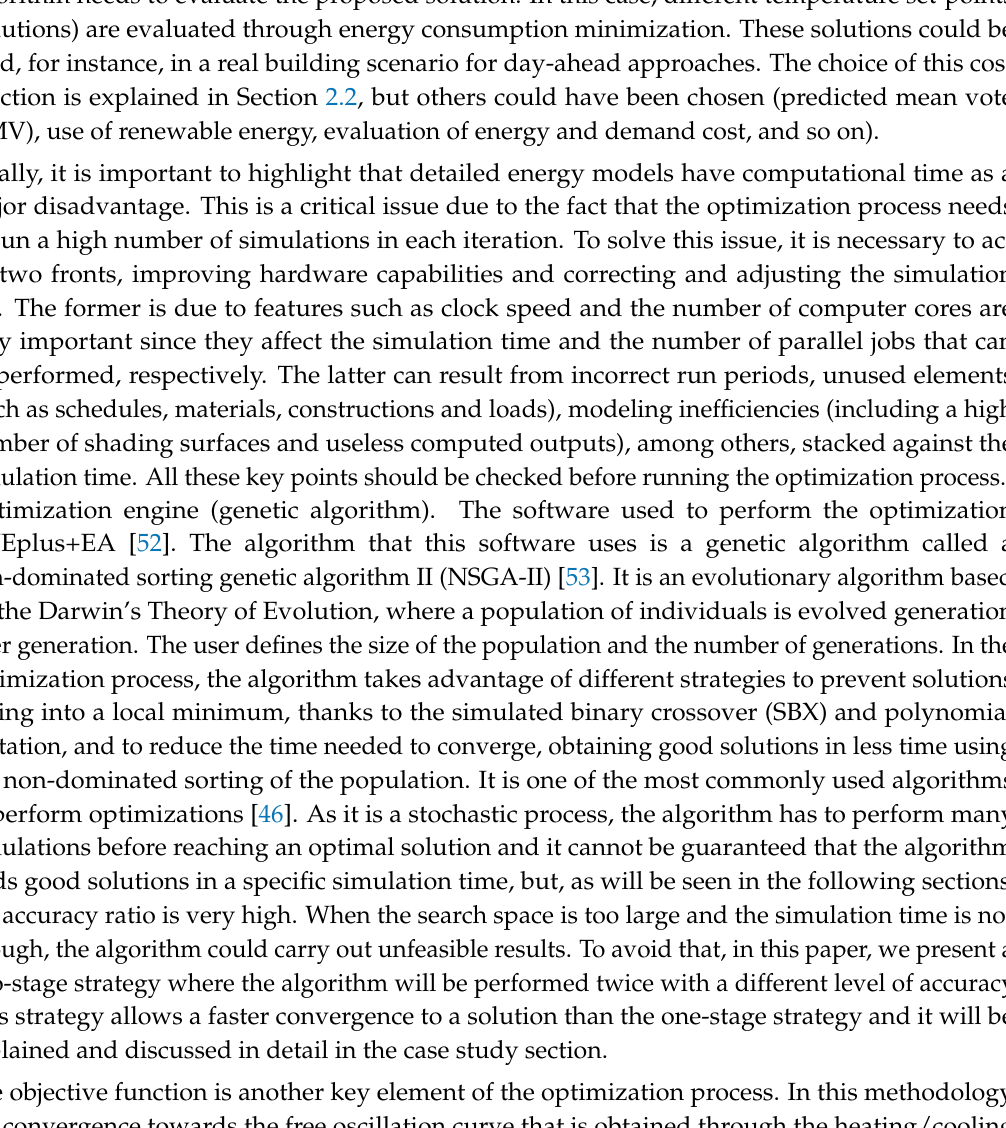
Figure 1: the weather forecast and the file with the measured temperatures of the